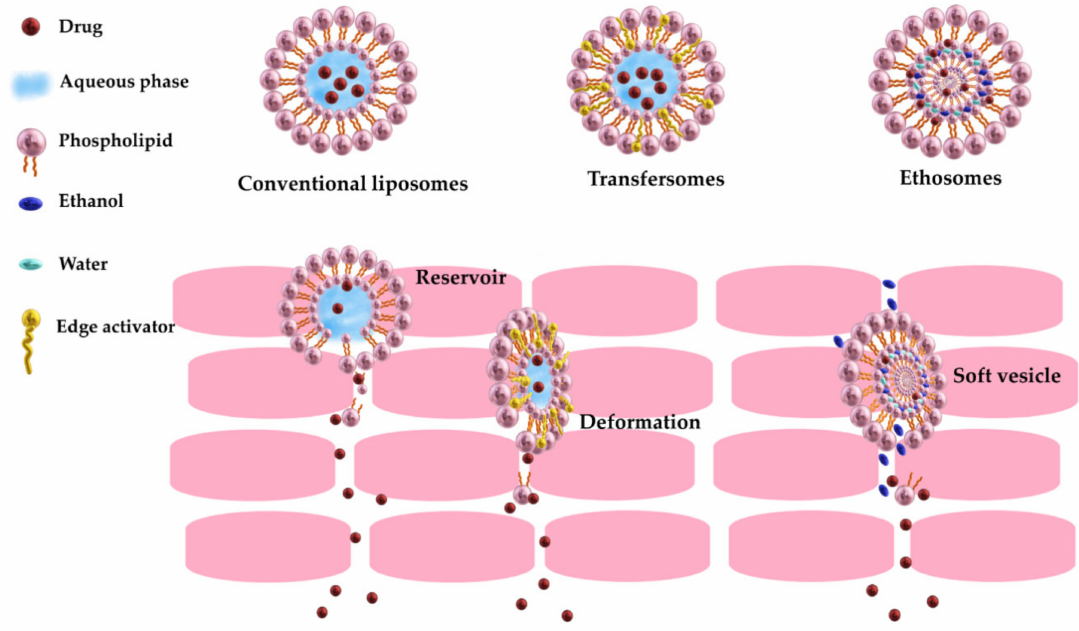
Figure 6. Schematic illustration of the penetration mechanism of conventional liposomes, transfersomes, and ethosomes.